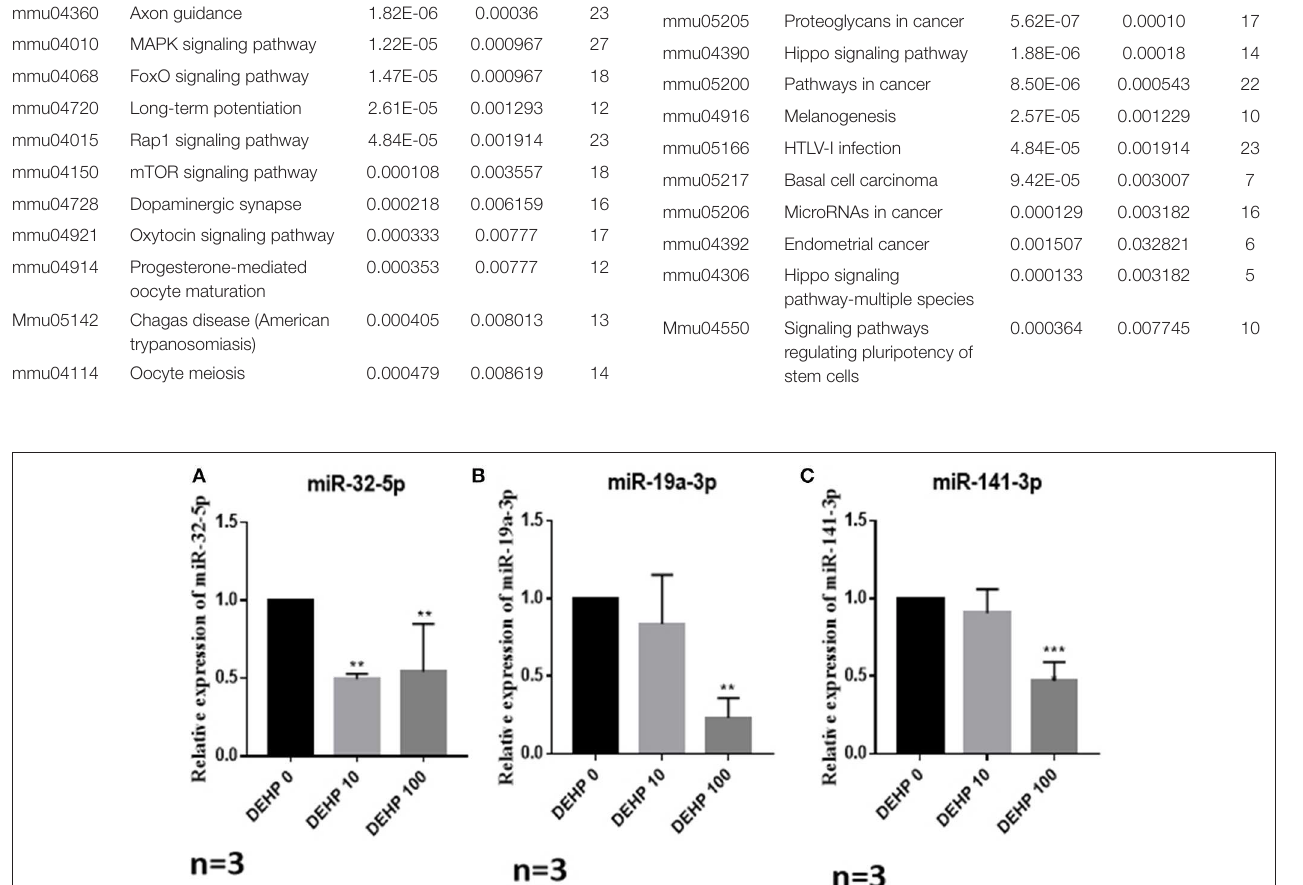
FIGURE 5 | Verification of miRNAs expression by qRT-PCR. (A) miRNA expression of miR-32-5p, (B) miRNA expression of miR-19a-3p, (C) miRNA expression of miR-141-3p. The results are presented as mean ± SD of at least three independent experiments. ** P < 0.01, *** P < 0.001.